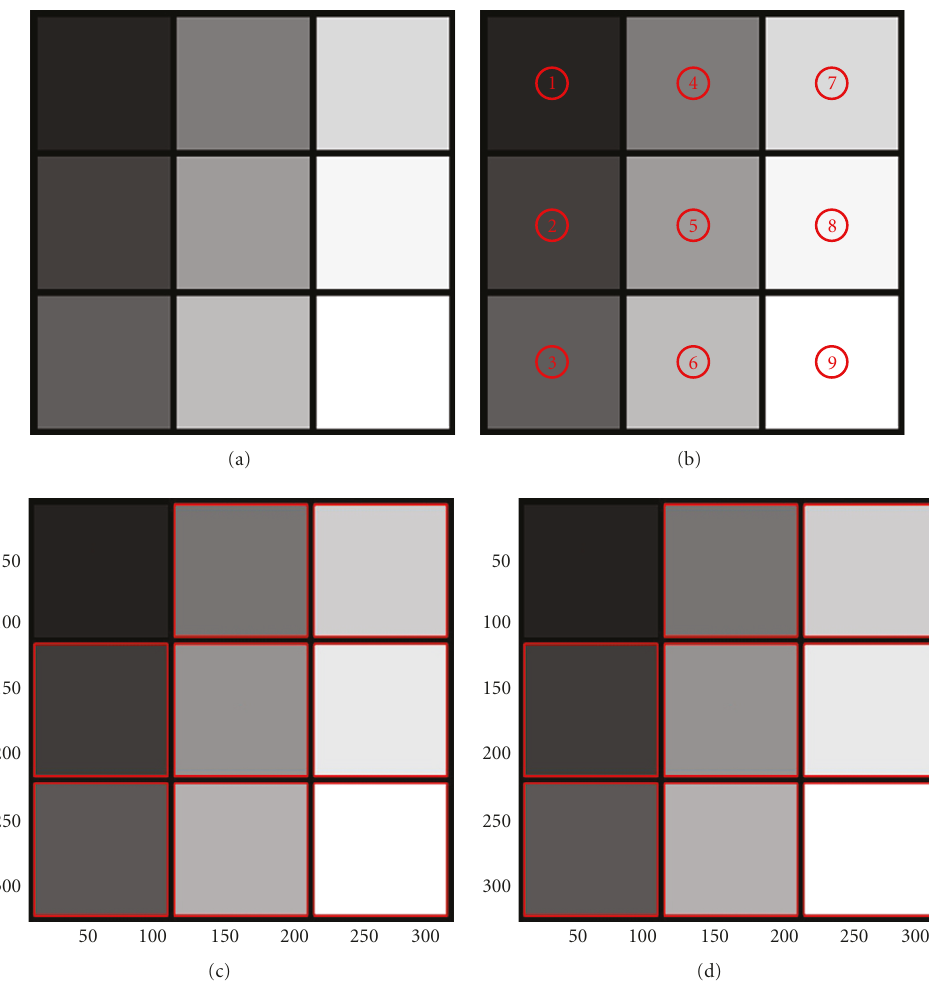
Figure 4: (a) Original image. (b) The number of each blocks. (c) Segmentation result obtained by threshold level set method. (d) Segmentation result obtained by multi-threshold level set method.